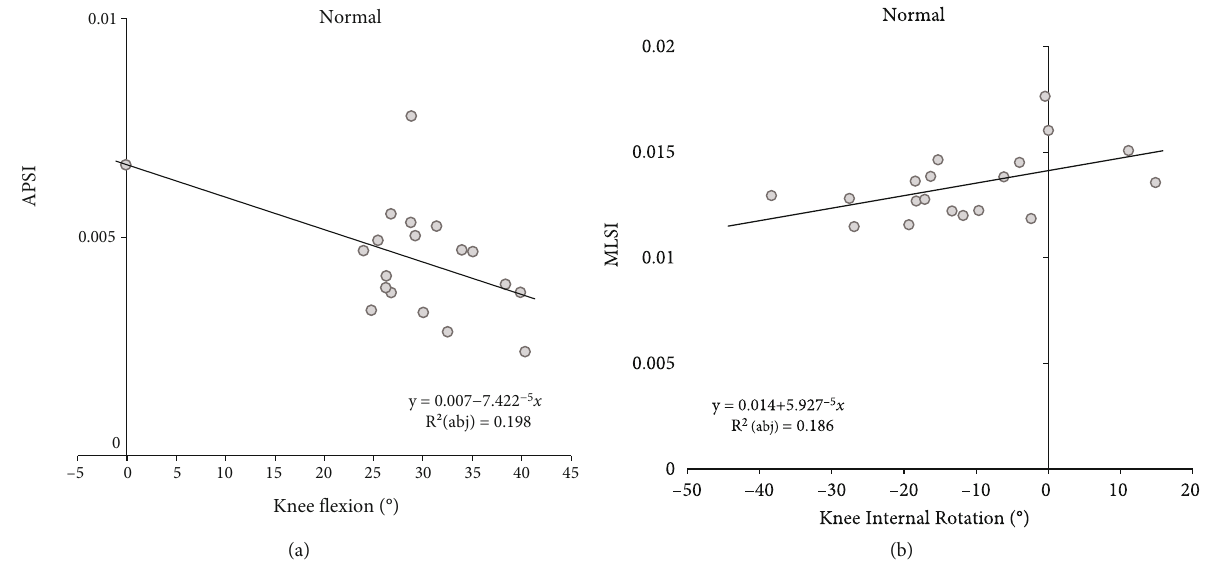
Figure 3: Results of linear regression analysis to normal group. (a) Results of linear regression analysis to normal group APSI. (b) Results of linear regression analysis to normal group MLSI. Abbreviations: APSI: anteroposterior stability index; MLSI: mediolateral stability index; adj: adjusted.